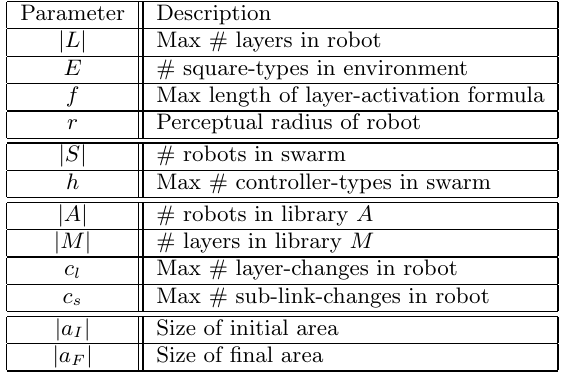
Table 1: Parameters for Reactive Swarm Morpho- genesis